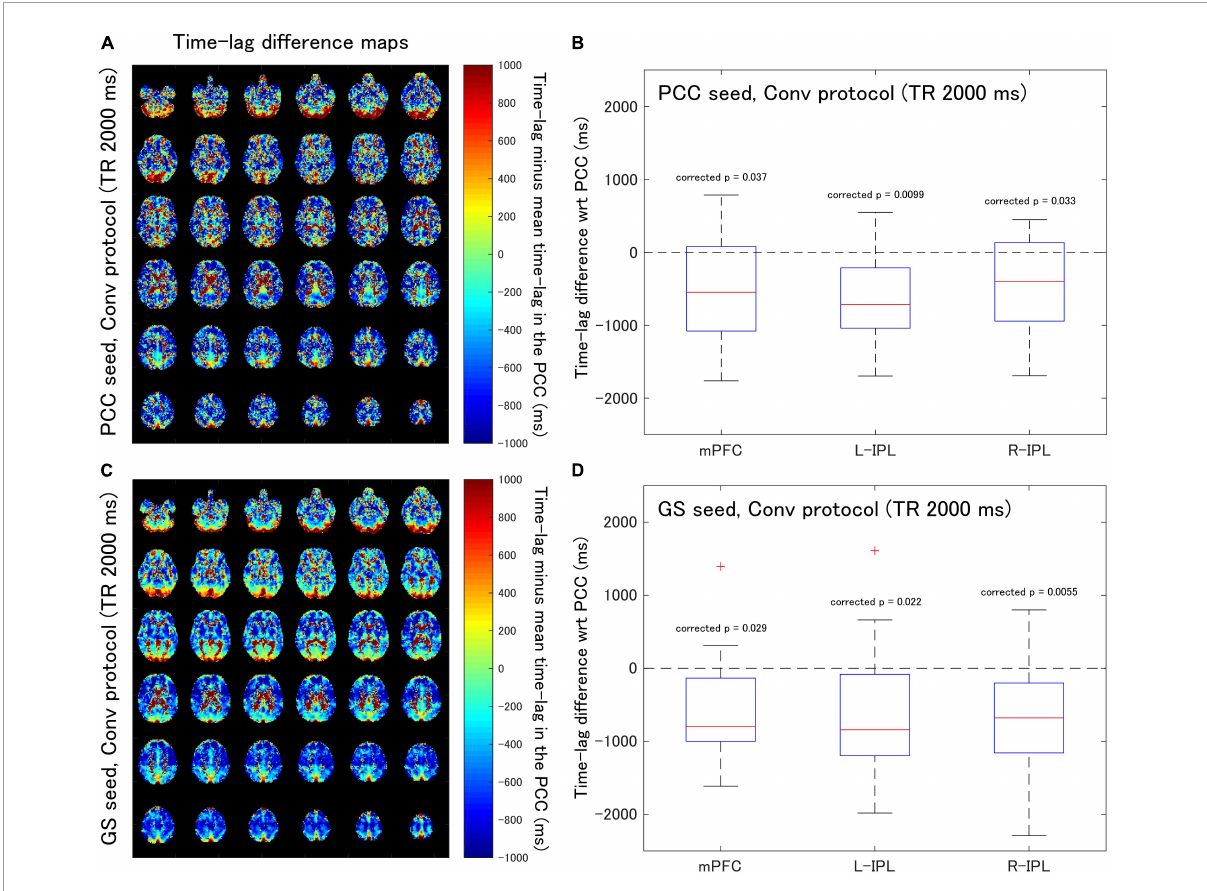
FIGURE2 Assessment of the difference in time-lag between the PCC and each of the DMN nodes for data acquired with the Conv protocol (TR = 2,000 ms). Eighteen healthy female volunteers participated in this study. (A) Time-lag difference maps calculated using the PCC seed. (B) Box-whisker plots of the time-lag difference estimated using the PCC seed for each of the mPFC, L-IPL, and R-IPL ROIs. (C) Time-lag difference maps calculated with the GS seed. (D) Box-whisker plots of the time-lag difference estimated using the GS seed for each of the mPFC, L-IPL and R-IPL